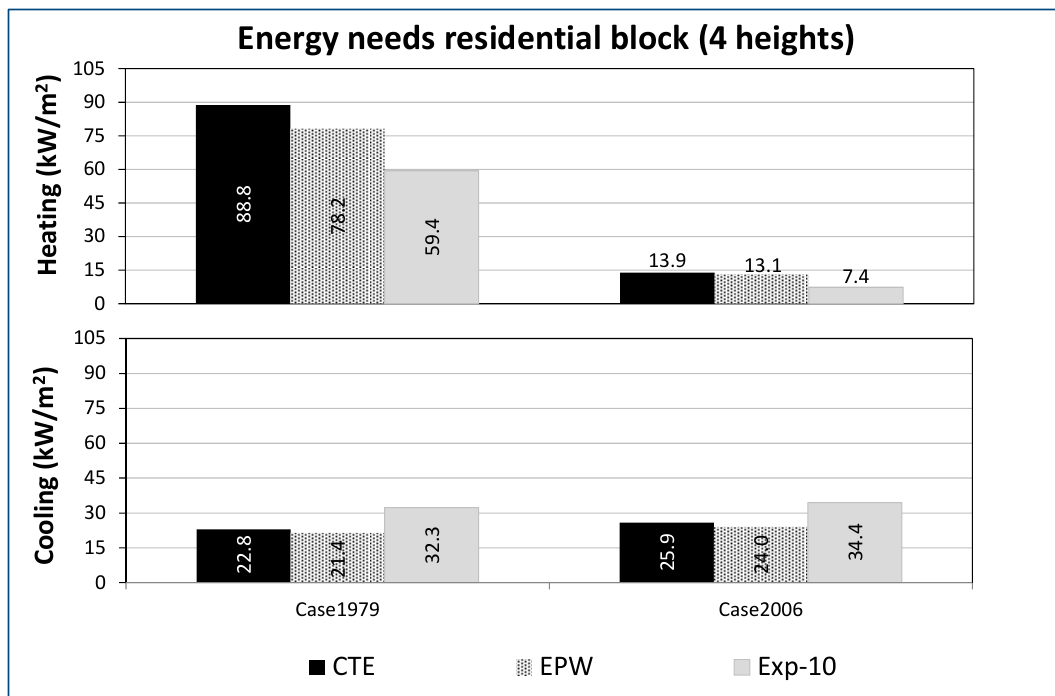
Figure 12. Cooling and heating loads obtained with TRNSYS for the three databases studied in Madrid.